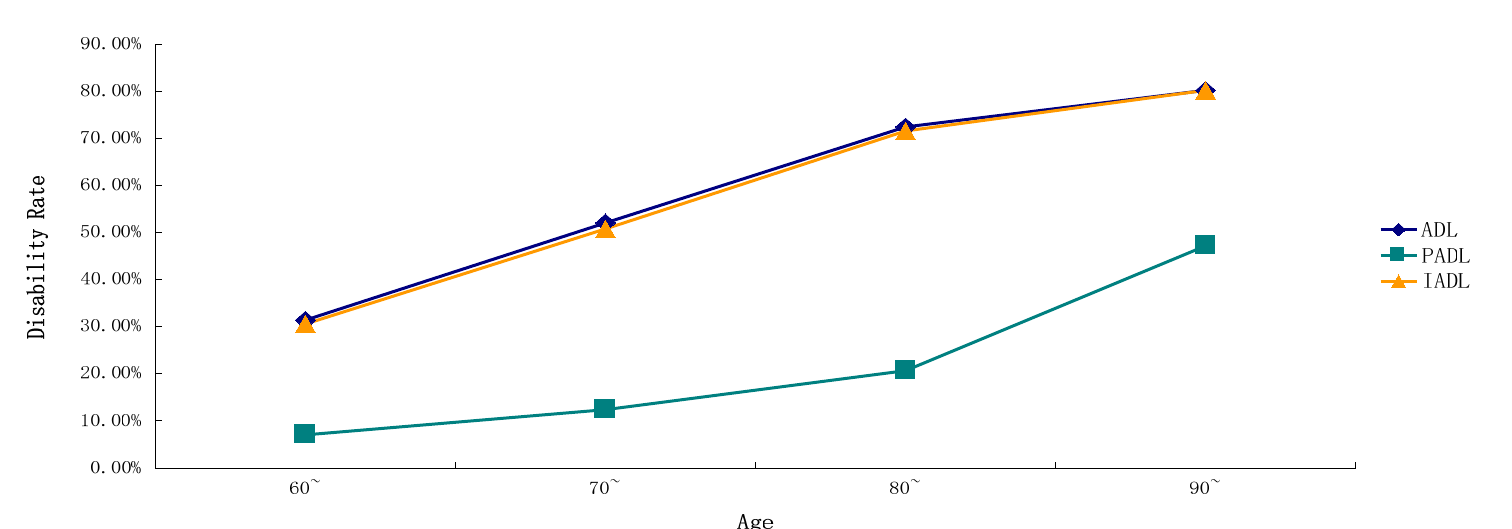
Figure 1. Disability rates of ADL, PADL, and IADL among the elderly at different ages.